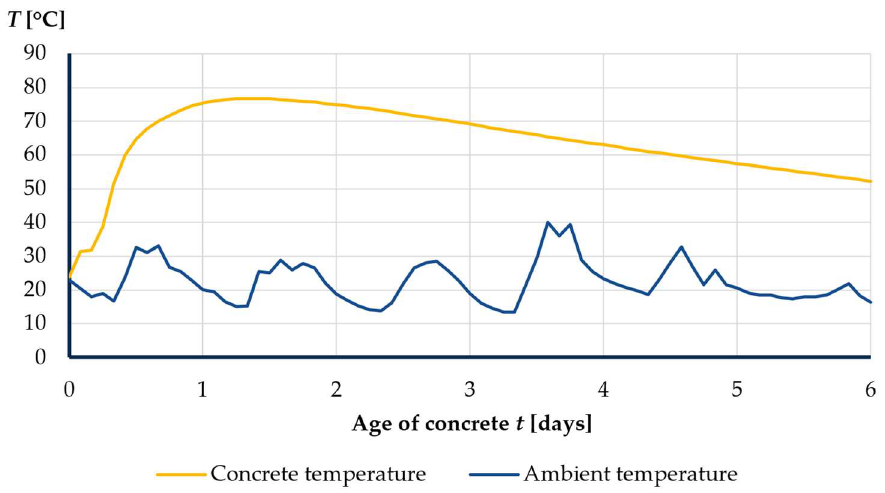
Figure 2. Temperature of concrete inside the superstructure in the first few days.